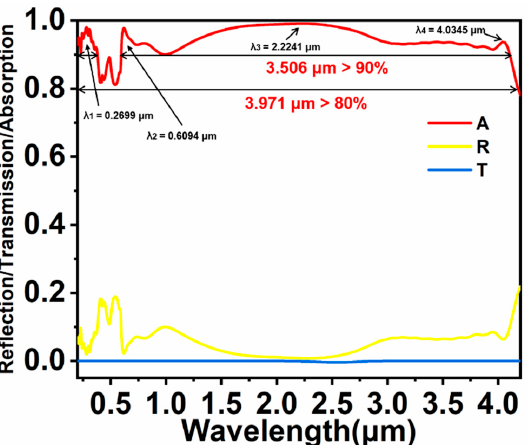
Figure 2. Optical spectra of the colloidal crystal-array-based solar energy absorber. Table 1. Absorption range of different structures with an absorption rate of more than 90%. Reference Structure